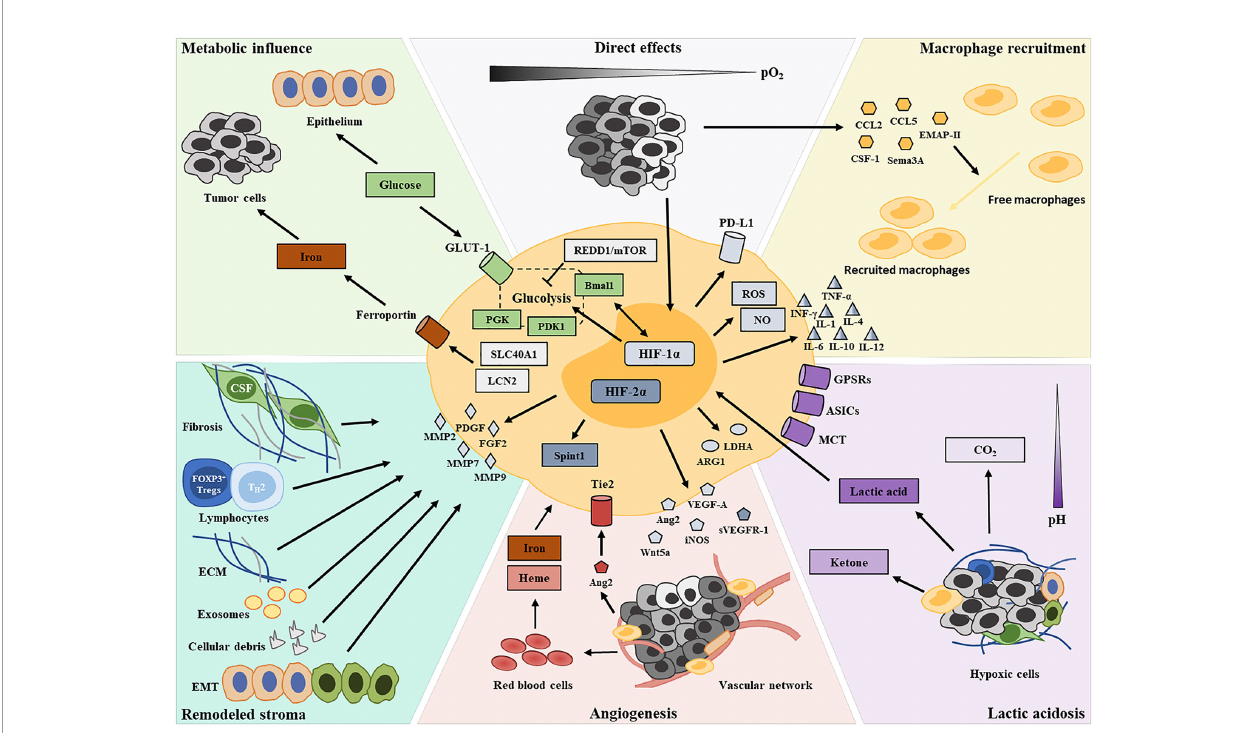
FIGURE 1 | Graphical summary depicting the contributors of TAM functional transformation in the hypoxic